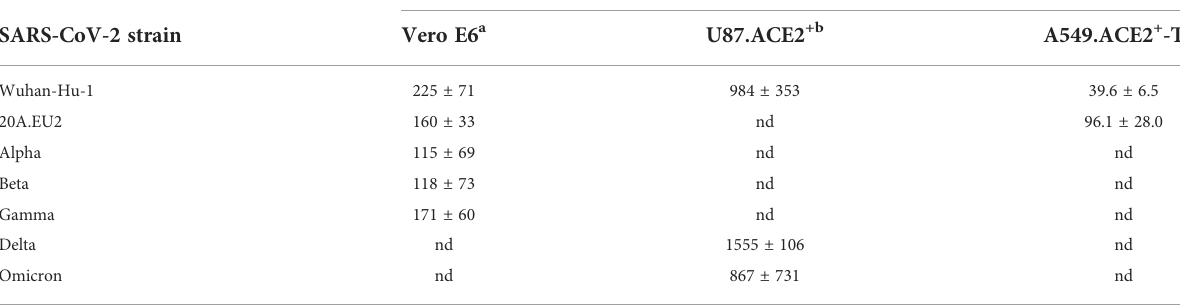
TABLE 1 Antiviral activity of UDA against live SARS-CoV-2 virus in different cell